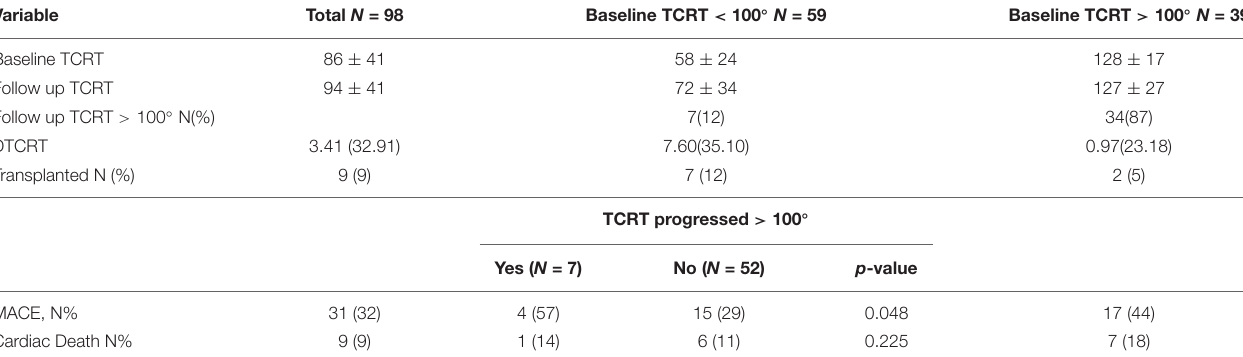
TABLE 6 | Longitudinal changes of TCRT according to baseline values dichotomized at 100 ◦